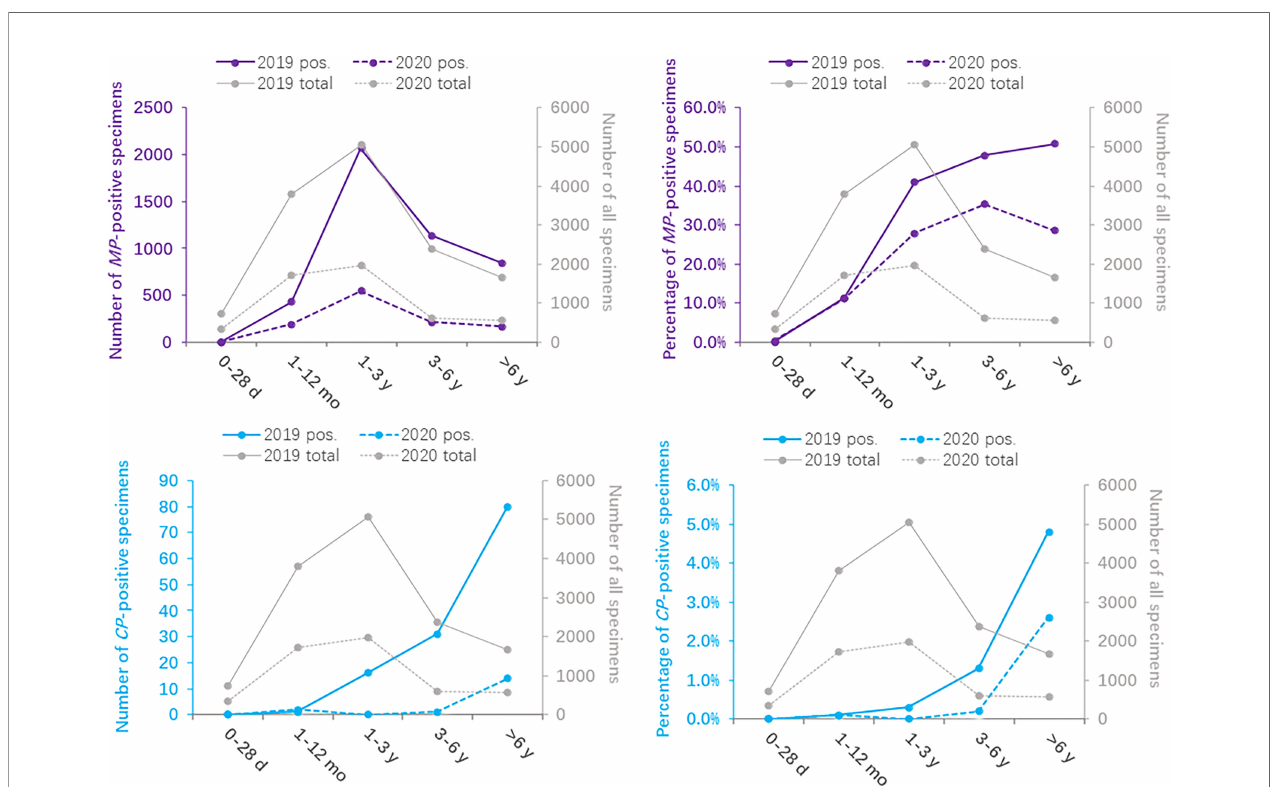
FIGURE 2 | Distribution of Mycoplasma pneumoniae- and Chlamydia pneumoniae- positive specimens based on months between 2020 (during the COVID-19 pandemic) and 2019 (before the COVID-19 pandemic).